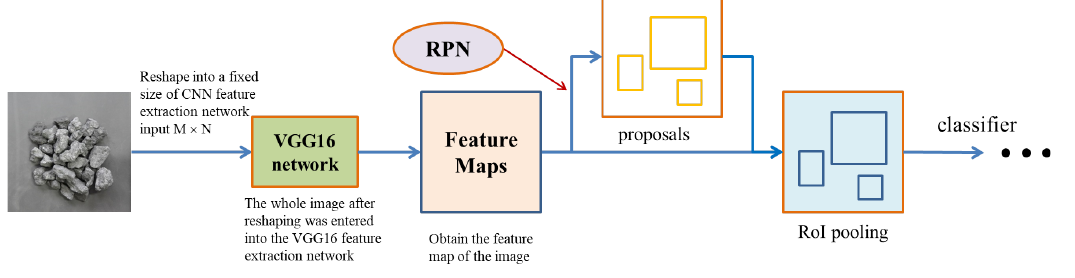
Figure 4. Principle of Faster R-CNN.